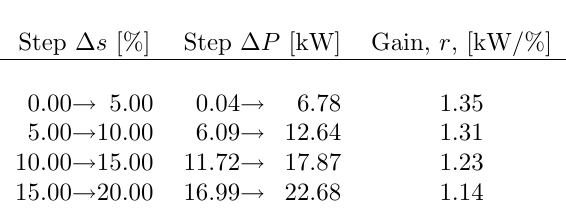
Table 3: Gain, r , for each step in ∆ s after t = 1 . 0 × 10 4 s. Step ∆ s [%] Step ∆ P